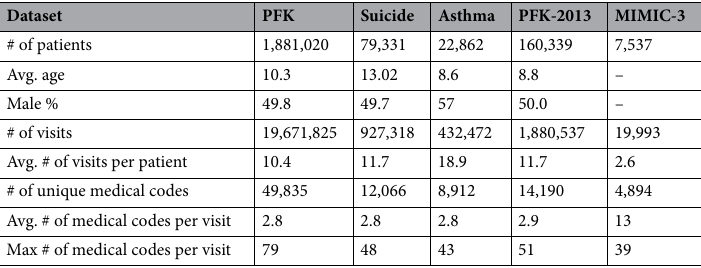
Table 1. Statistics of the datasets.